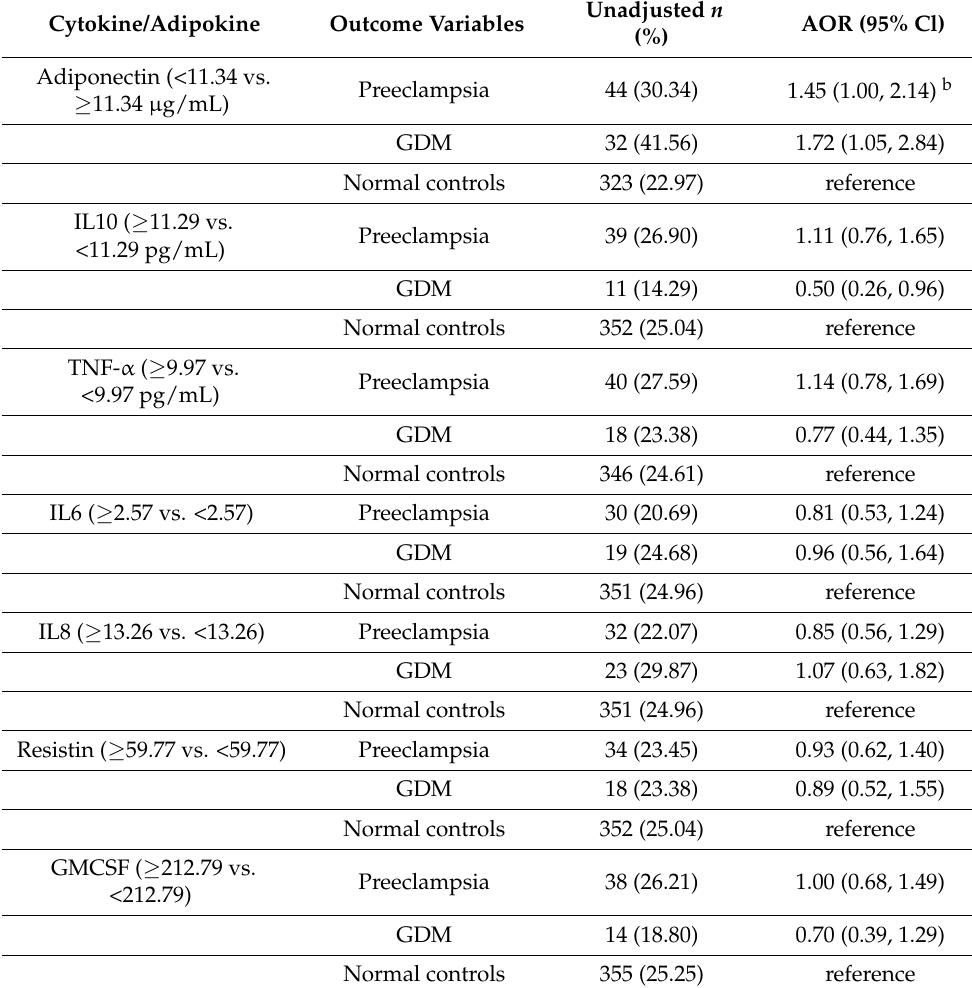
Unadjusted n AOR (95% Cl) (%)